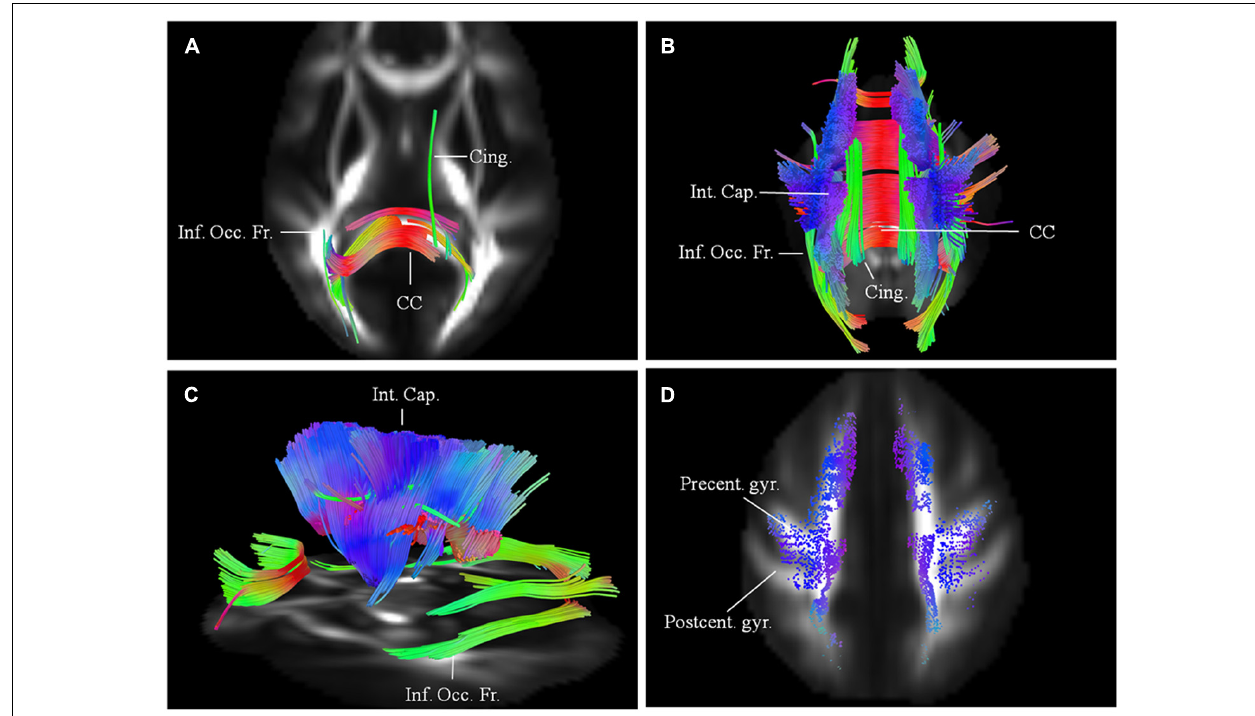
FIGURE 2 | (A) Baseline diffusion connectometry analysis for patient 1, demonstrated the affected areas as being inferior occipito-frontal